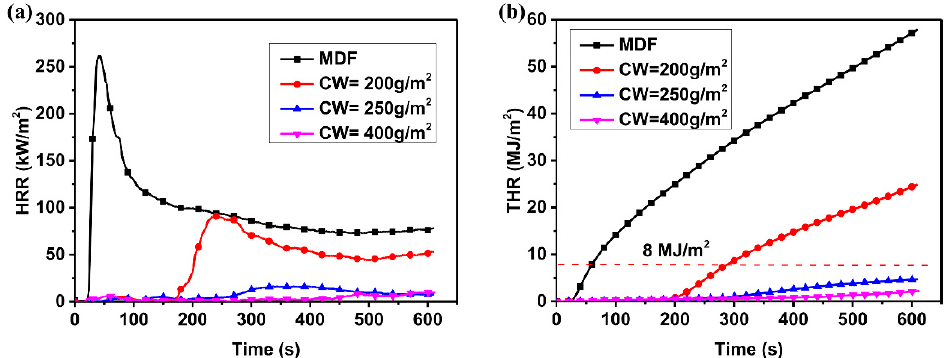
Figure 1. HRR ( a ) and THR ( b ) of MDF and MDF coated by A3P1 with different coating weights.